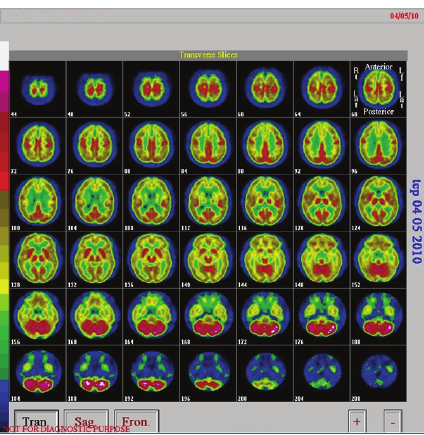
Figure 3: Brain 18-FDG-PET showing diffuse cerebral hypome- tabolism with cerebellar hypermetabolism (usually reported finding in